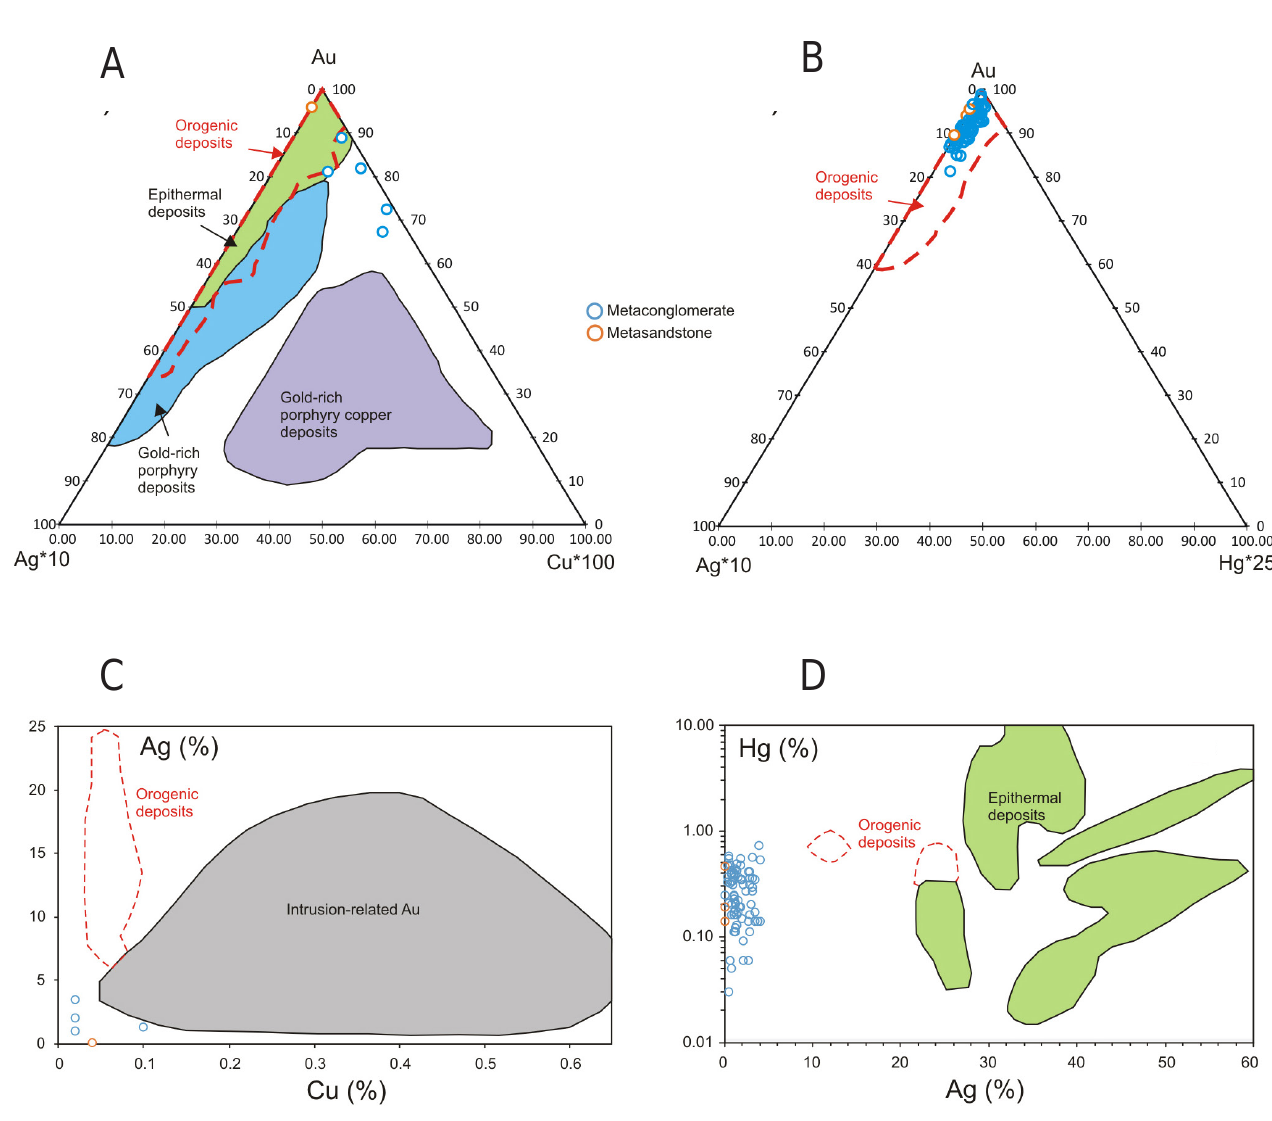
Figura 17 - Chemical composition of gold particles of the Castelo de Sonhos gold deposit compared to potential sources. (A) Au – Ag*10 – Cu*100; fields for epithermal, Au-rich porphyry and Au-rich porphyry copper deposits are from Townley et al. (2003), and for orogenic deposits are from Omang et al. 2015. (B) Au – Ag*10 – Hg*25; field for orogenic deposits from Omang et al. (2015). (C) Cu – Ag; fields for intrusion-related and orogenic gold are from Chapman et al. (2011). (D) Ag – Hg; fields for epithermal and orogenic gold from Chapman et al.